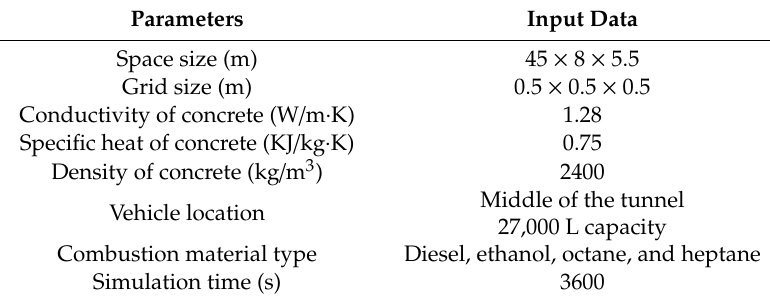
Table 1. Analysis conditions by hazardous material